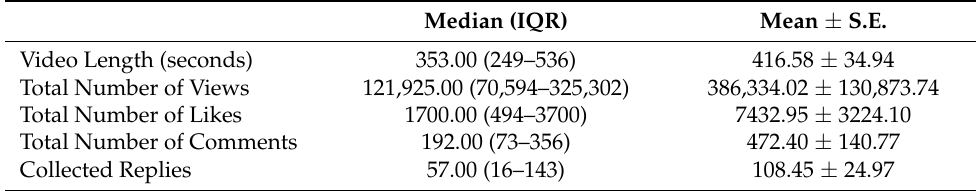
Table 1. General characteristics of selected videos.